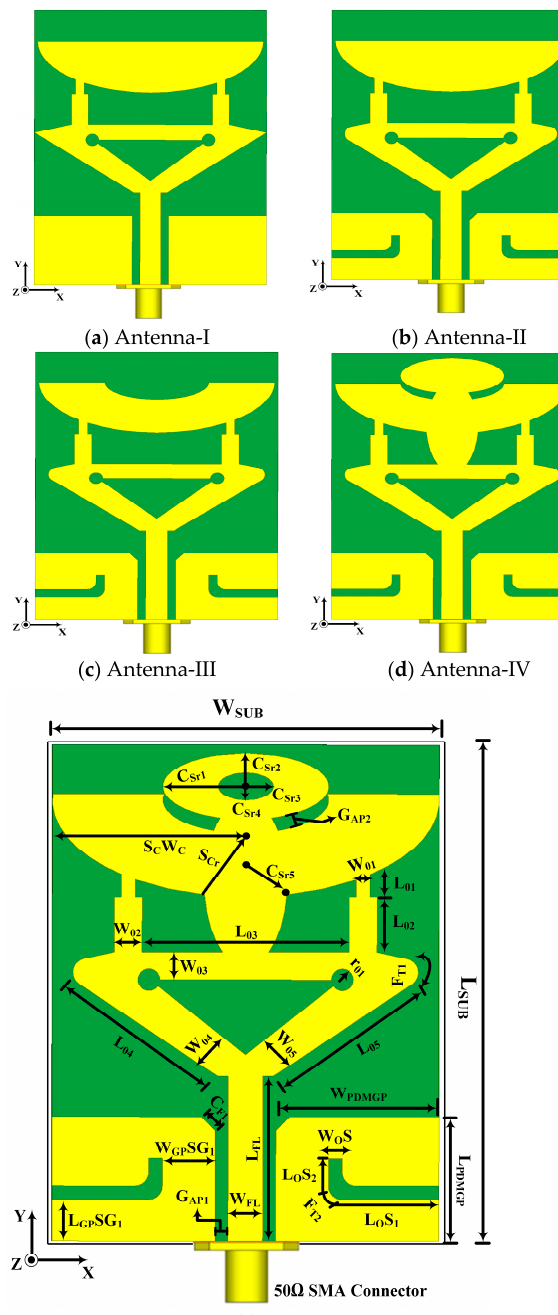
Figure 1. Development stages of proposed antenna:( a ) simple S C IT S CPW-fed with partial defected metal ground plane (PDMGP), ( b ) loaded L-stub with PDMGP and fillet radiator, ( c ) truncated semicircular (S C ) radiator ( d ) loaded elliptically cavity-based (C B ) stubs, ( e ) proposed antenna design geometries (top view) .